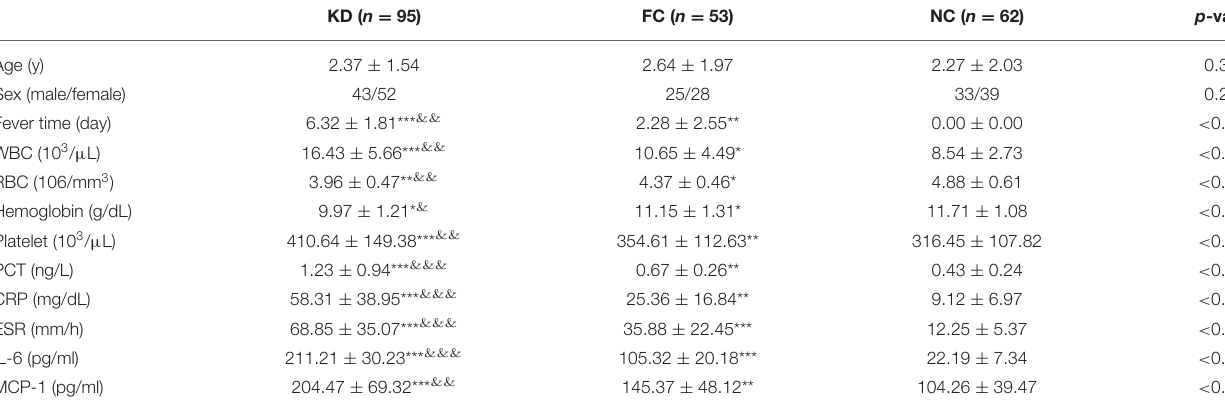
TABLE 1 | Cohort characteristics.